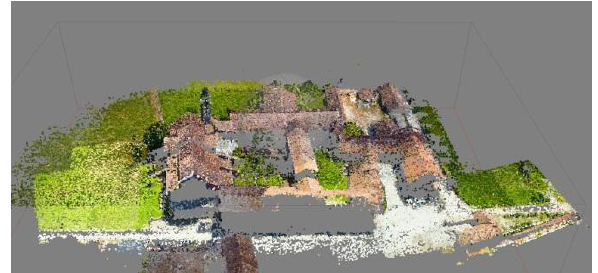
Figure 10. Calculated Tie Points in Photoscan